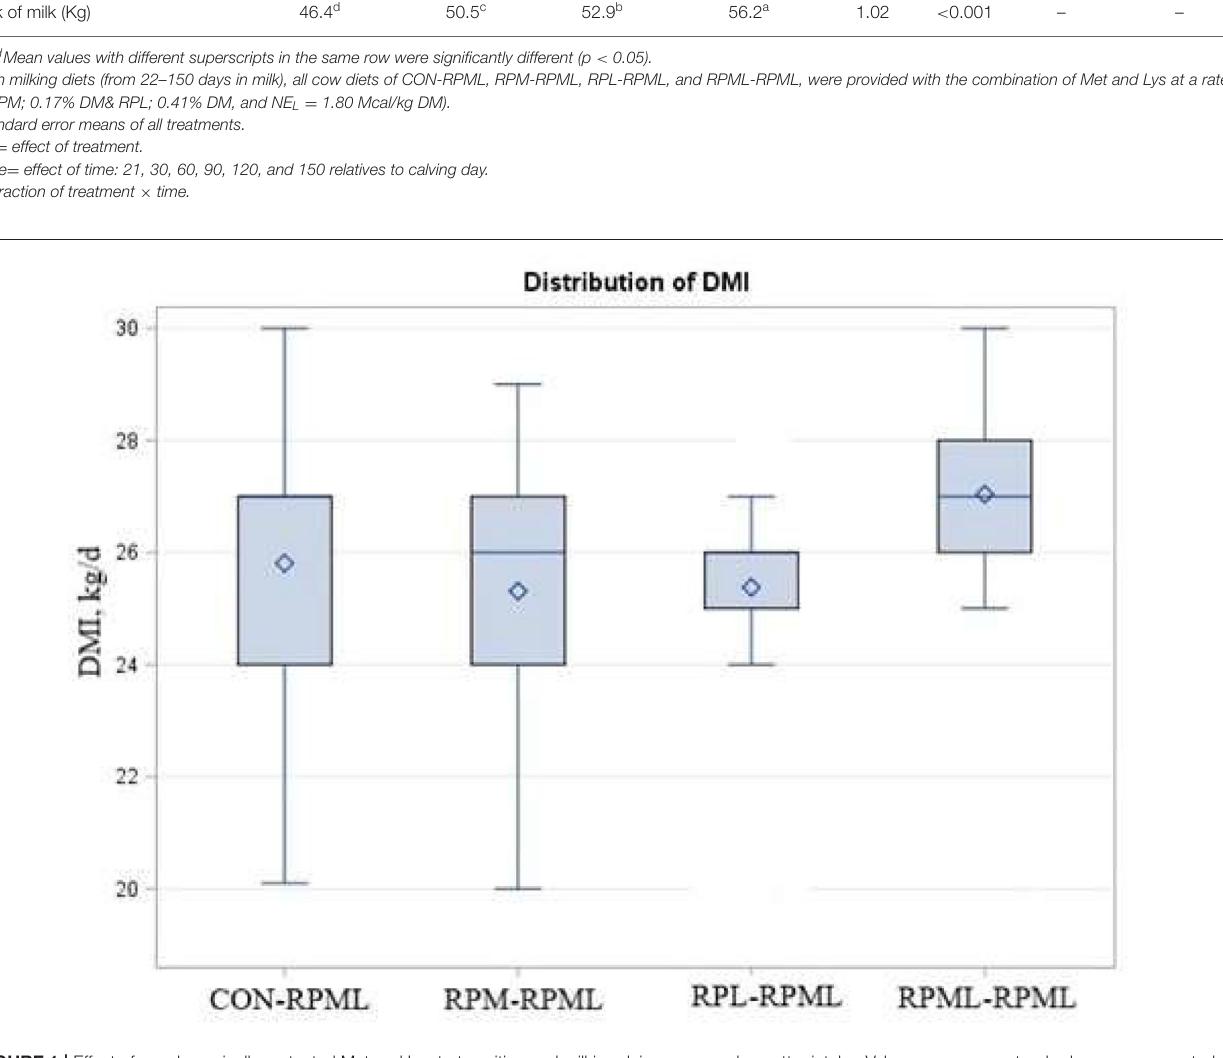
had a greater ( p = 0.02) EB than cows in RPL – RPML group (2.16 Mcal) at 120 DIM, and also cows in RPML – RPML (5.15